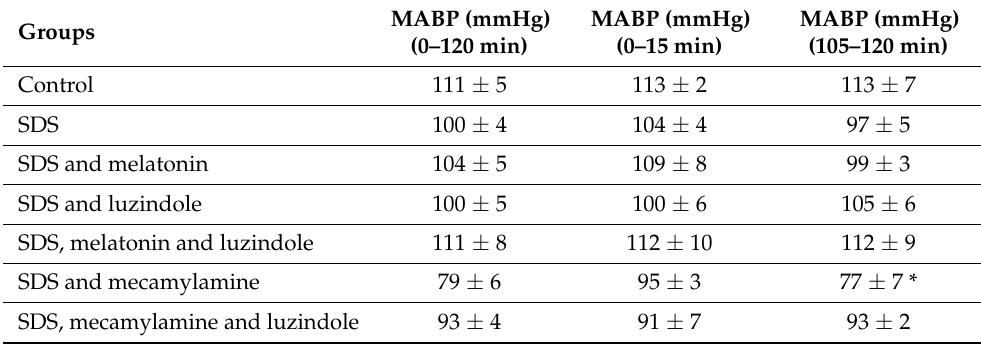
Table 1. The mean ( ± SEM) arterial blood pressure (MABP) of the seven different groups ( n = 6) dur- ing the rat single-pass perfusion experiments. The interval 0–120 min shows the average throughout the full experiment, 0–15 min during the first 15 min, and 105–120 during the last 15 min.